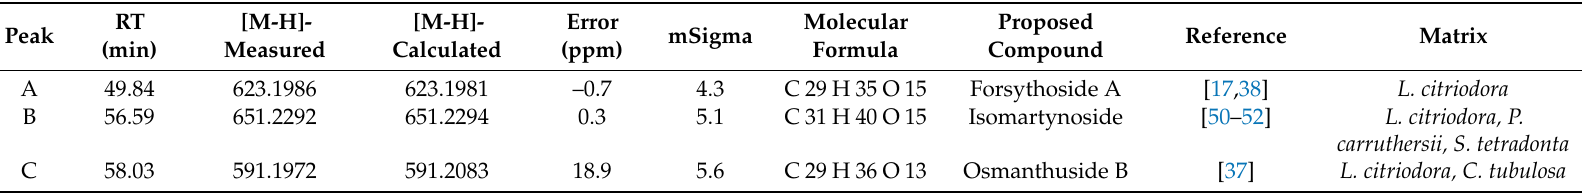
Table 3. Retention time (RT) and mass spectral data of the compounds characterized only in fractions from the commercial lemon verbena extract (PLX ® 10) by RP-HPLC-ESI-TOF-MS in negative